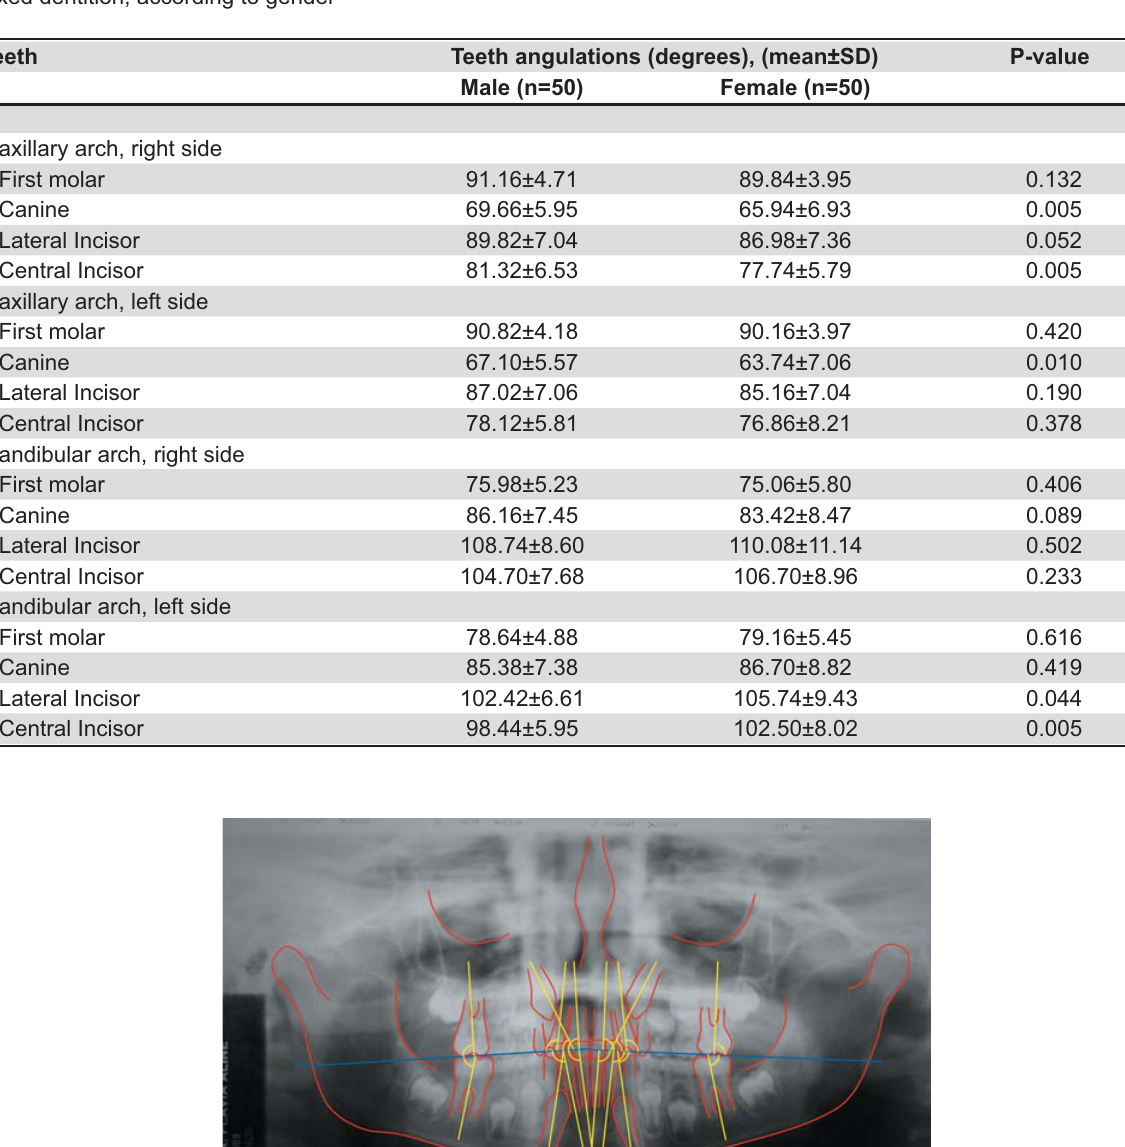
Table 1- Mesiodistal angulation of different teeth in children [mean age 8.9 years ± standard deviation (SD=0.76)] with mixed dentition, according to gender